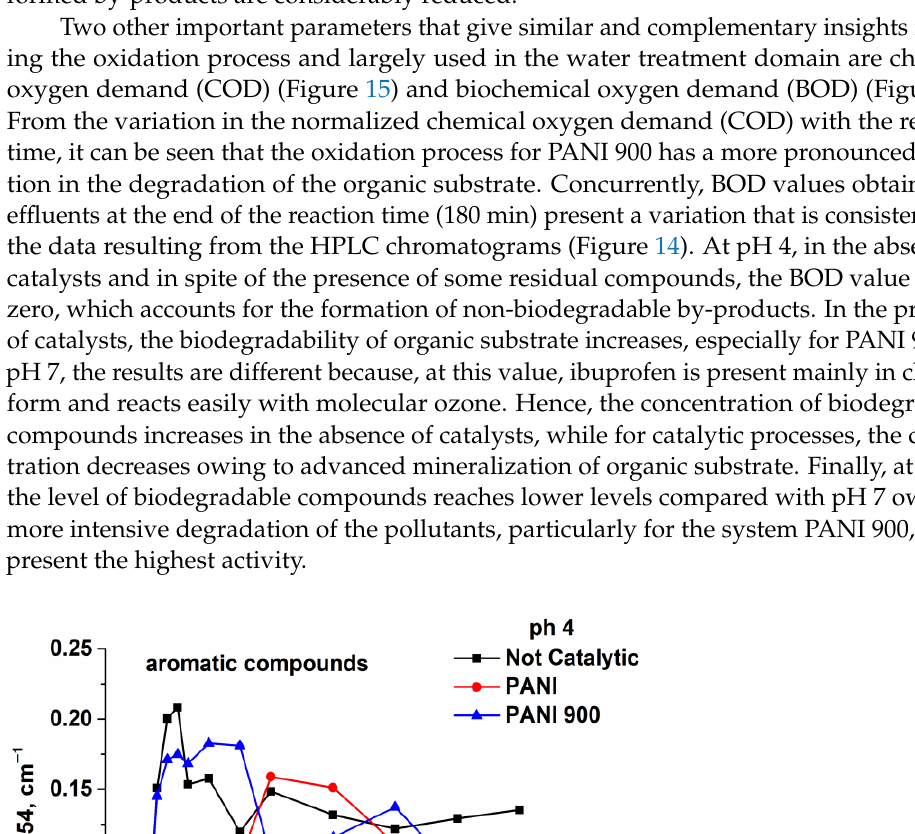
Figure 13. Variation in UV254 absorbance with reaction time at three pH values.